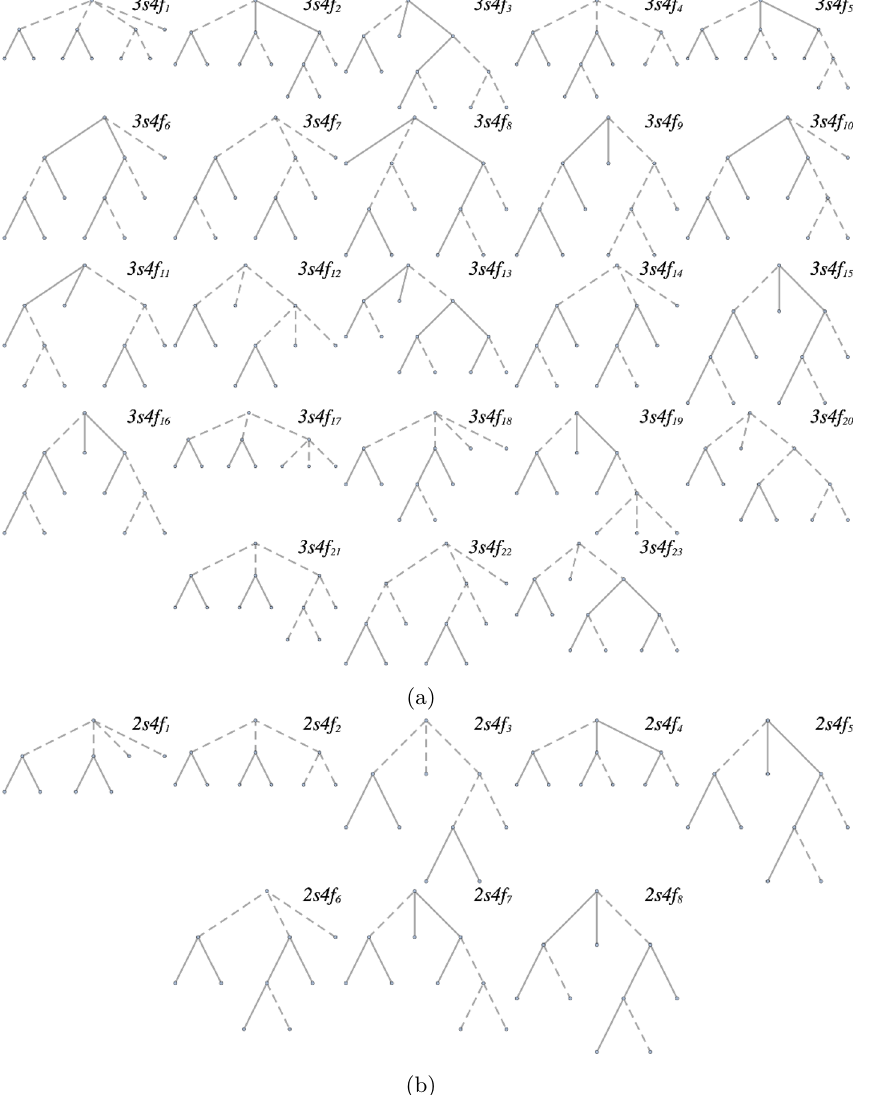
Figure 9. (a) The figure shows the tree-level topologies relevant to 3 s 4 f operators. Topolo- gies 3 s 4 f 3 , 3 s 4 f 13 , 3 s 4 f 20 and 3 s 4 f 23 imply one exotic field that couples only to other exotics